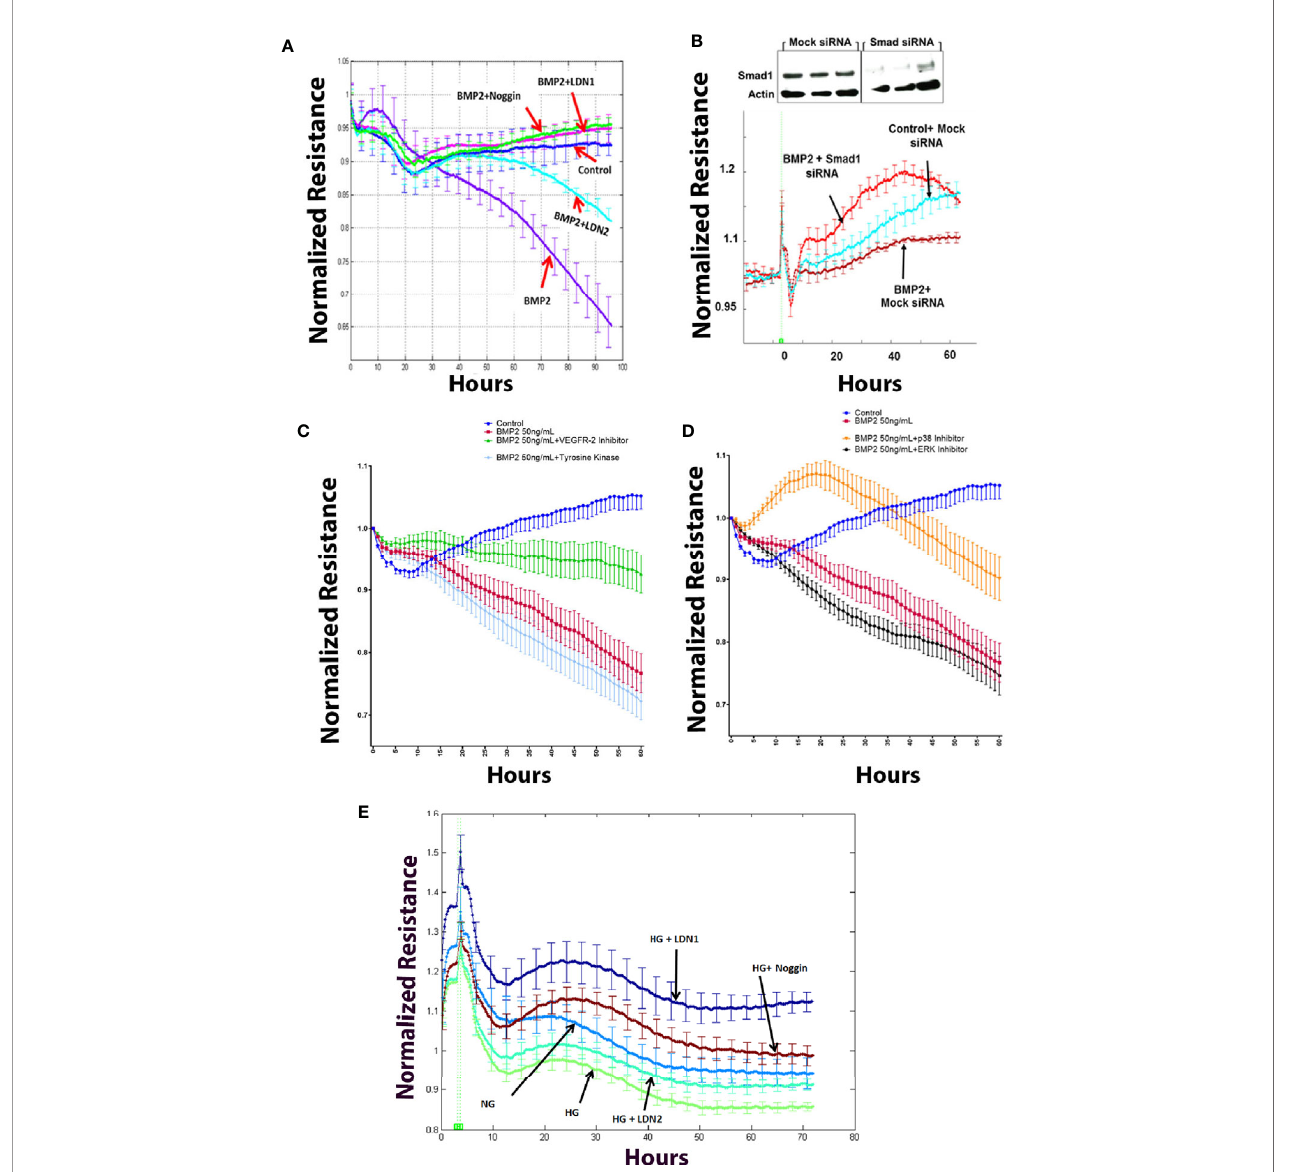
FIGURE 5 | Effect of BMP2 on trans-endothelial electrical resistance (ECIS). ECIS analysis showing signi fi cant decreases in the trans-endothelial cell electrical resistance (TER) of human retinal endothelial cells (HRECs) treated with rhBMP2 (50ng/ml for 4 – 5 days). Effect of rhBMP2 was signi fi cantly attenuated by the inhibitors of BMP receptors, LDN1 and LDN2 as well as by the noggin that prevents BMP2 from binding its receptors (A) . Effect of rhBMP2 on the TER of HRECs was also attenuated by silencing smad1 using smad1 small interfering RNA (siRNA) compared to the mock siRNA (B) . Inhibition of VEGFR2 by SU5416, 10 m M (C) , or p38 by SB202190, 10 m M (D) showing signi fi cant attenuation of the rhBMP2-induced reduction of the TER in HRECs. However, inhibition of tyrosine kinase by G-6055 9Genistein 10µM (C) or MERK by U0126 10µM (D) did not prevent the effect of BMP2-induced changes in the TER of HRECs. Similarly, incubation of HRECs in CM of HG-treated HRECs induced signi fi cant decrease in TER over time and this effect was attenuated by noggin, LDN1, and LDN2. (E) Data points represent the mean of 4 – 6 wells at the same time point+SE. Two way ANOVA followed by a post hoc Tukey ’ s test. It was used to compare different treatments over